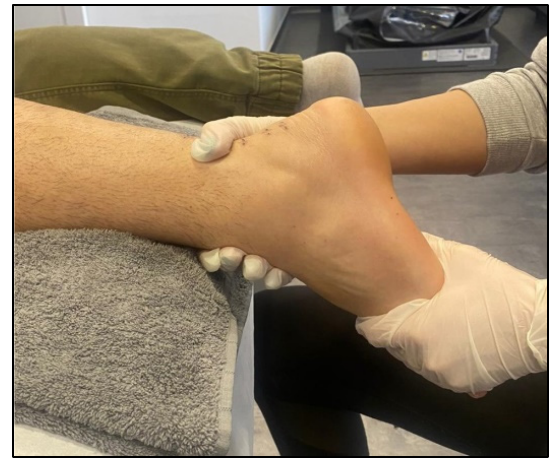
Figure 3. Manual therapy after Achilles tendinopathy.